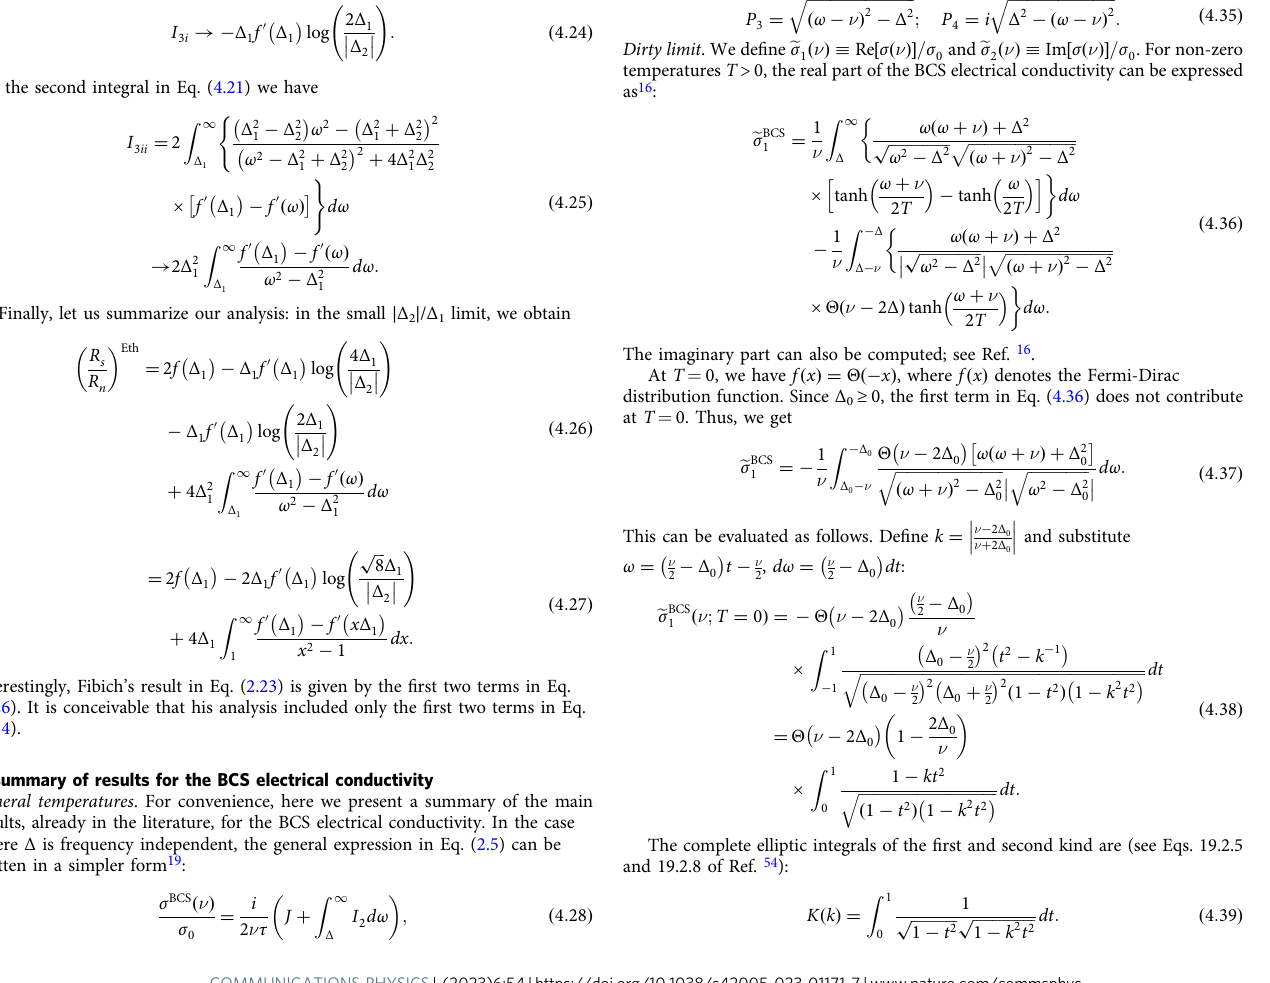
ffiffiffiffiffiffiffiffiffiffiffiffiffiffiffiffi p ¼ ω 2 (cid:1) Δ 2 2 ffiffiffiffiffiffiffiffiffiffiffiffiffiffiffiffiffiffiffiffiffiffiffiffiffiffiffiffi Δ 2 (cid:1) ω (cid:1) ν ð